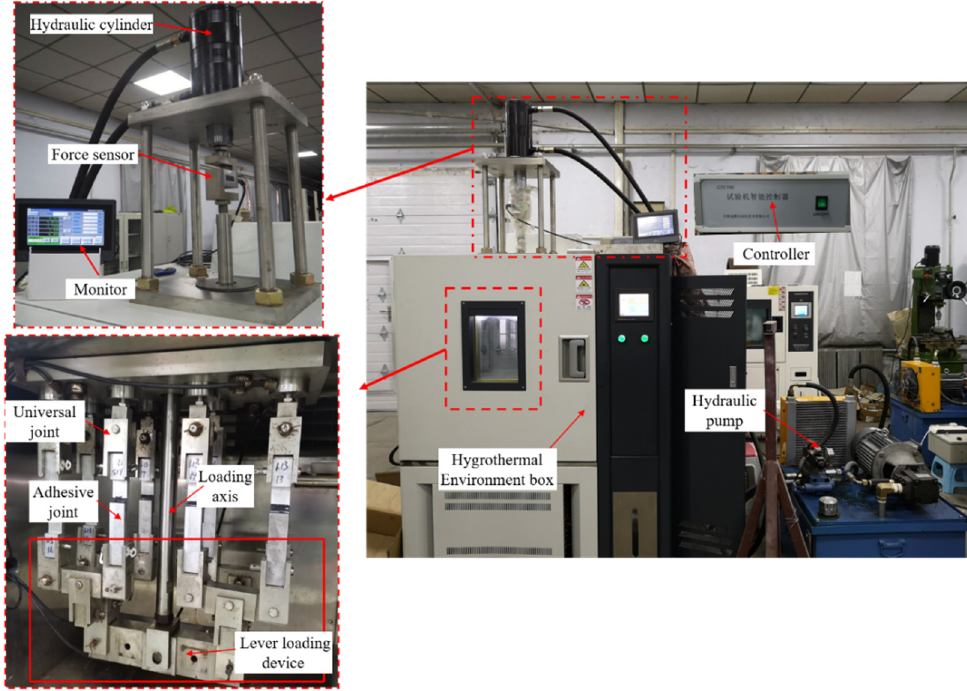
Figure 2. Environment and load coupling test device. Table 3. Testing